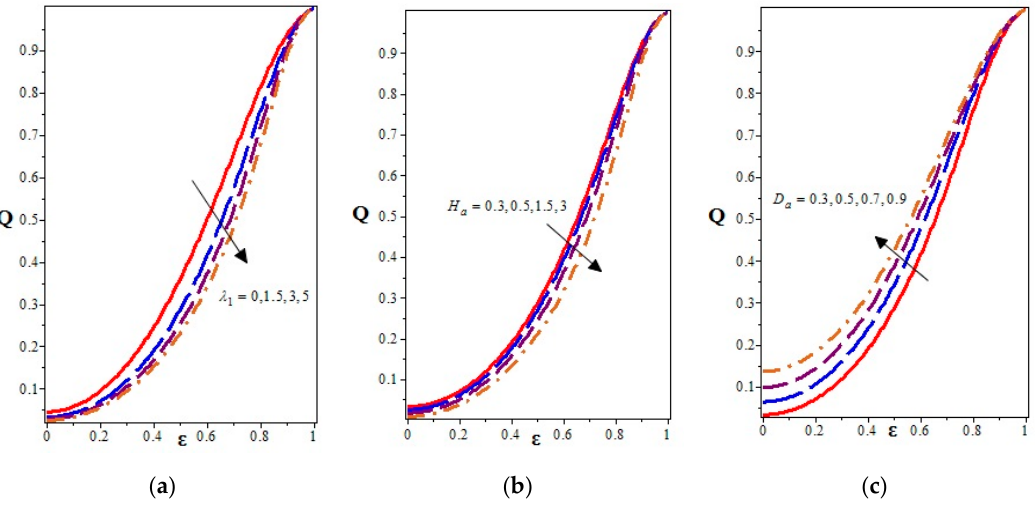
Figure 4. Volume flow rate Q versus ε for different values of: ( a ) λ 1 , ( b ) H a , and ( c ) D a , keeping other parameters fixed as g t = 0.5, S t = 0.5, M = 0.1, g c = 0.5, S r = 0.5, S c = 0.1, ∆ p = 0.5, β = 0.4, and δ =